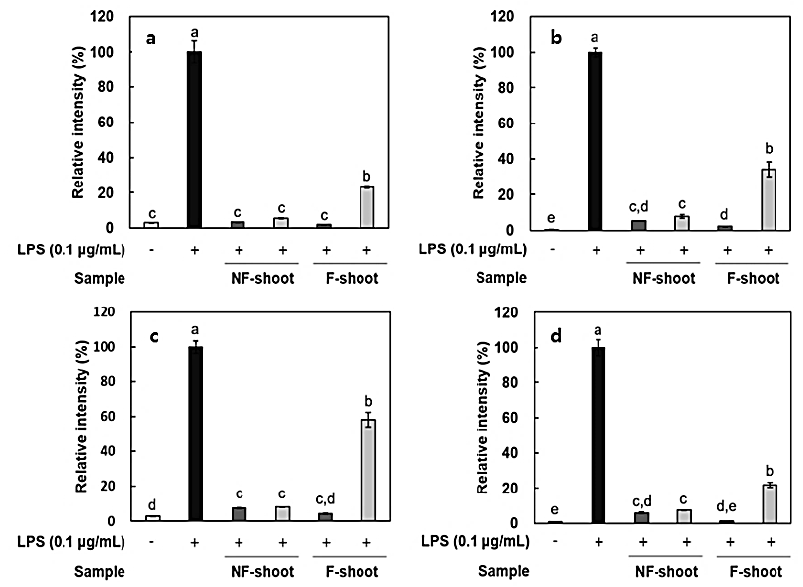
Figure 4. Relative expression of inflammatory mediators in LPS-stimulated RAW 264.7 cells treated with hydroponic ginseng shoot. ( a ), iNOS; ( b ), TNF- α ; ( c ), IL-6; and ( d ), IL-1 β . 200 µ g / mL; 100 µ g / mL. NF, non-fermented; F, fermented. Values are means ± standard deviation of triplicate experiments. Different letters in same column indicate significant differences as determined by Duncan’s multiple range tests ( p < 0.05). Different letters (a, b, c, and d) represent significant differences among samples.